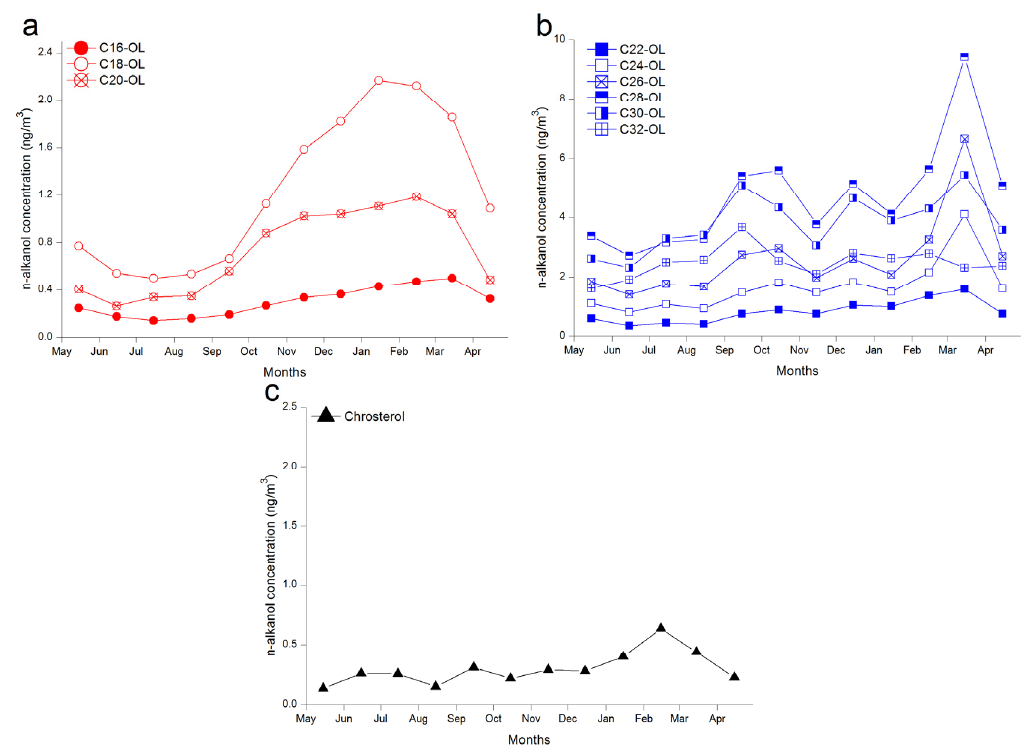
Figure 5. Temporal variations in individual alkanol concentrations of ambient air aerosols in south coastal Xiamen. ( a ) short-chain n -alkanols; ( b ) long-chain n-alkanols; and ( c ) cholesterols.